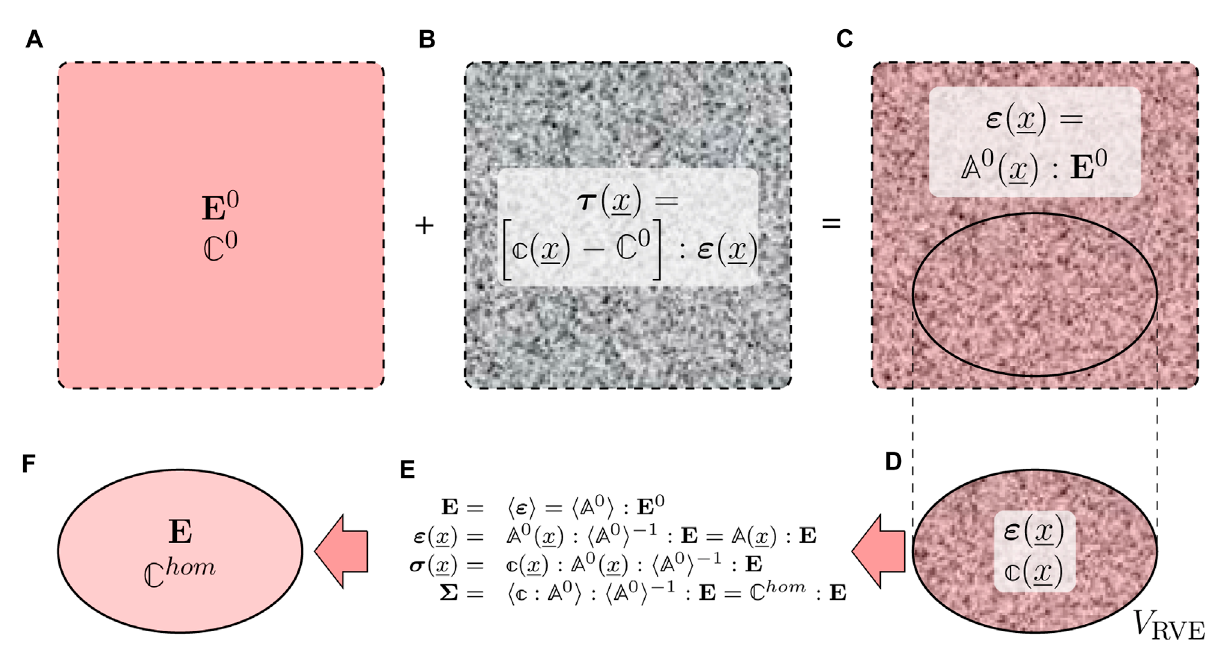
FIGURE 1 Illustration of elements making up the new homogenization scheme: (A) infinite homogeneous elastic matrix of stiffness ℂ 0 subjected to background (auxiliary) strains E 0 ; (B) same matrix undergoing equilibrated (polarization) stresses which are equivalent to the effect of fluctuations (𝕔( x )−ℂ 0 ) in microstiffness, 𝕔( x ) , around the homogeneous stiffness ℂ 0 , (C) sum of load cases (A) and (B) ; (D) selection of corresponding microstrains and microstiffnesses within a finite domain (RVE) characterizing the microheterogeneous material; (E) strain averaging over RVE, with ⟨•⟩ = 1 •( x ) d V ( x ) , and corresponding concentration and homogenization formulae; (F) macroscopic elastic representation of RVE. ∫ V RVE V RVE